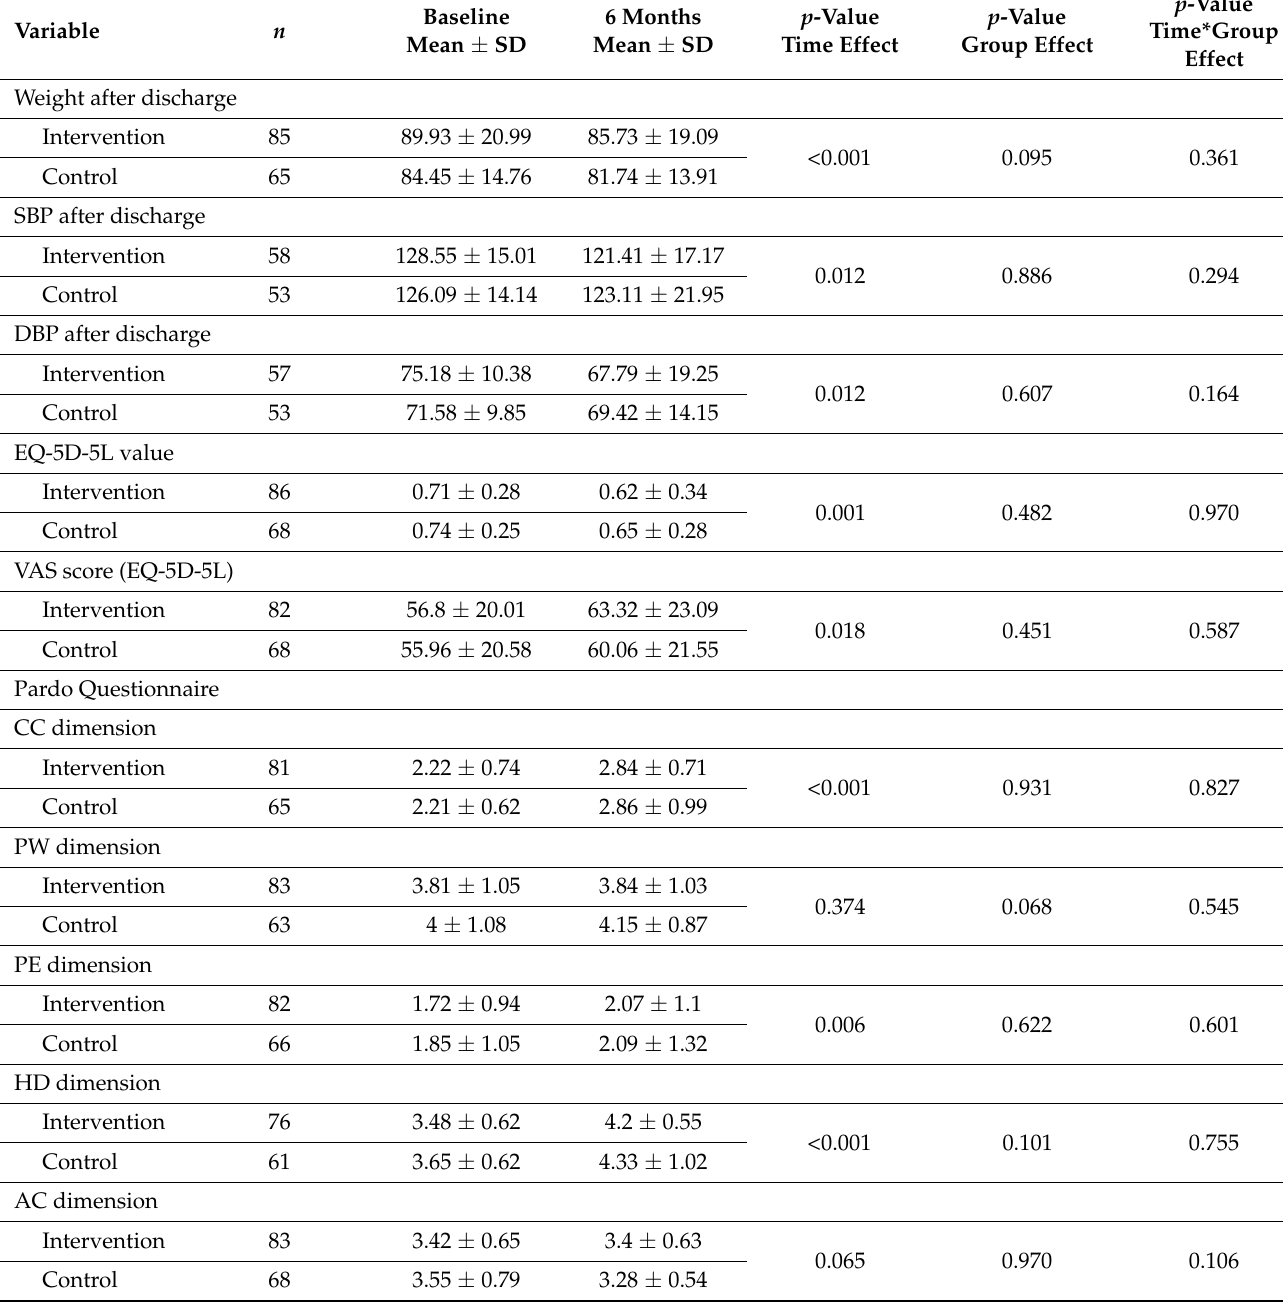
Table 4. Comparison of outcome variables between baseline and six